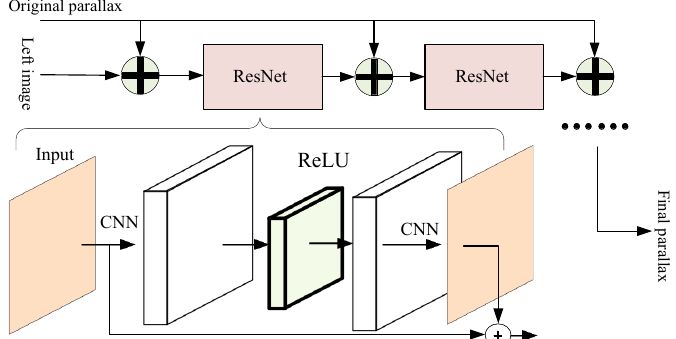
Figure 10. Adaptive sub-network.